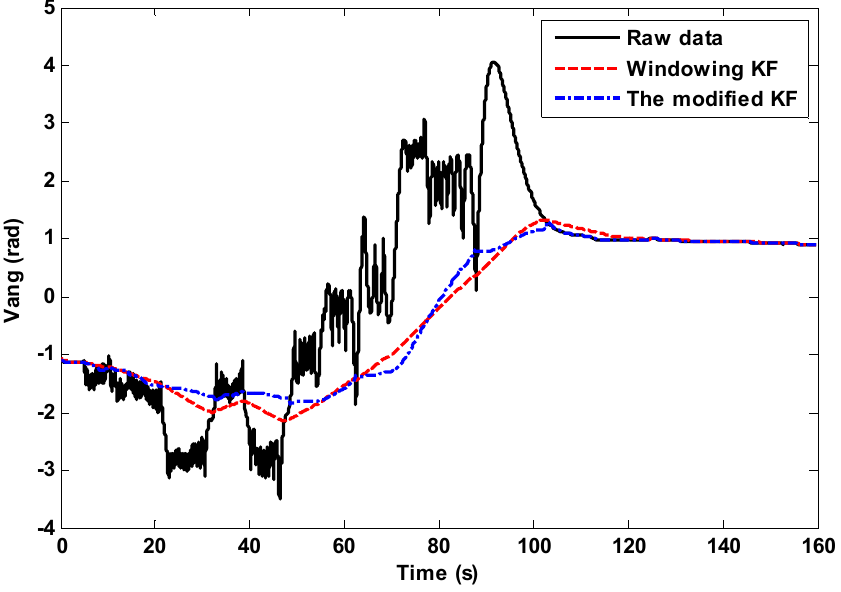
Figure 9. Performance comparison of two proposed KF methods (for PMU’s voltage angle signal).